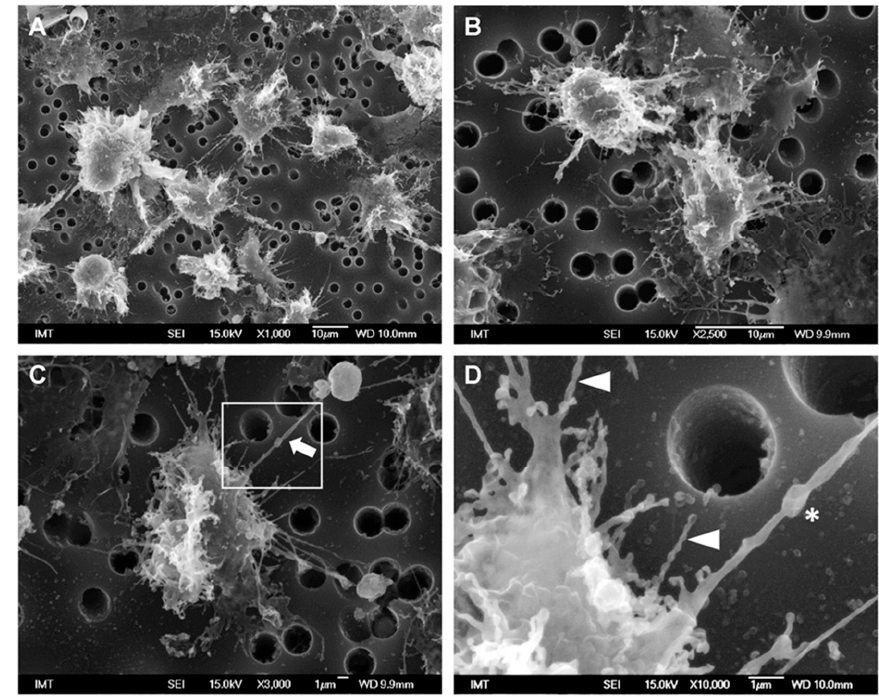
Figure 5. SEM images of M. galloprovincialis hemocytes incubated for 30 min with PS ‐ COOH suspensions (10 μ g/mL) in HS ( A , B , D ) Detail of cytoplasmic extensions observed in ( C ), indicating thicker filaments containing vesicles (asterisk), and filopodia with necklace ‐ like structure (arrowheads).